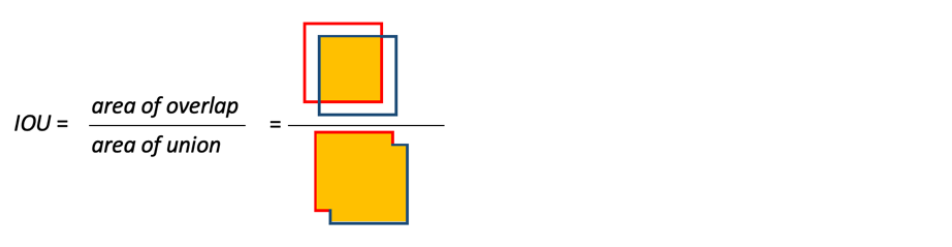
Figure 2. Graphical representation of the IoU mathematical expression in the Object Detection scope.